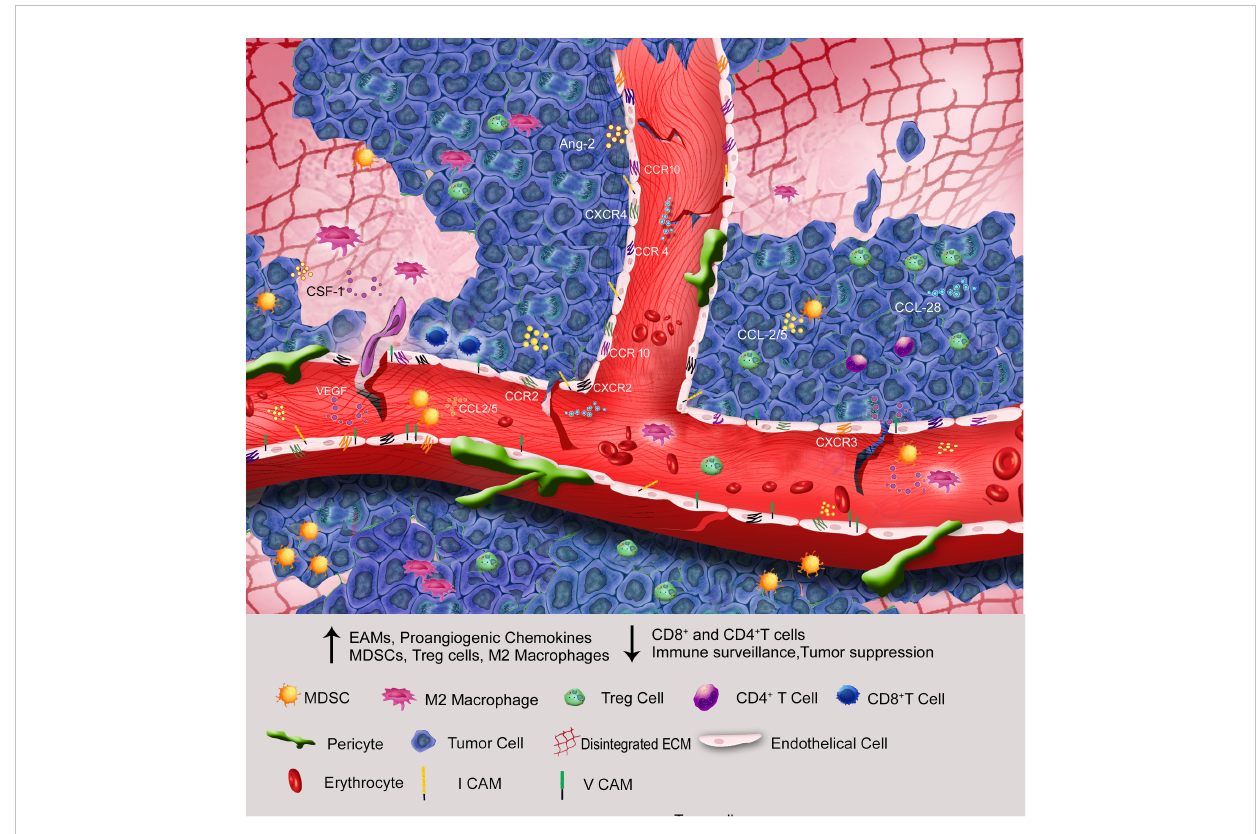
FIGURE 1 Through endothelial anergy, elevation of proangiogenic chemokines, cell adhesion molecules, and ECM disintegration, the hypoxic core of solid tumors attracts more immunosuppressive cells than immunostimulatory cells to the tumor